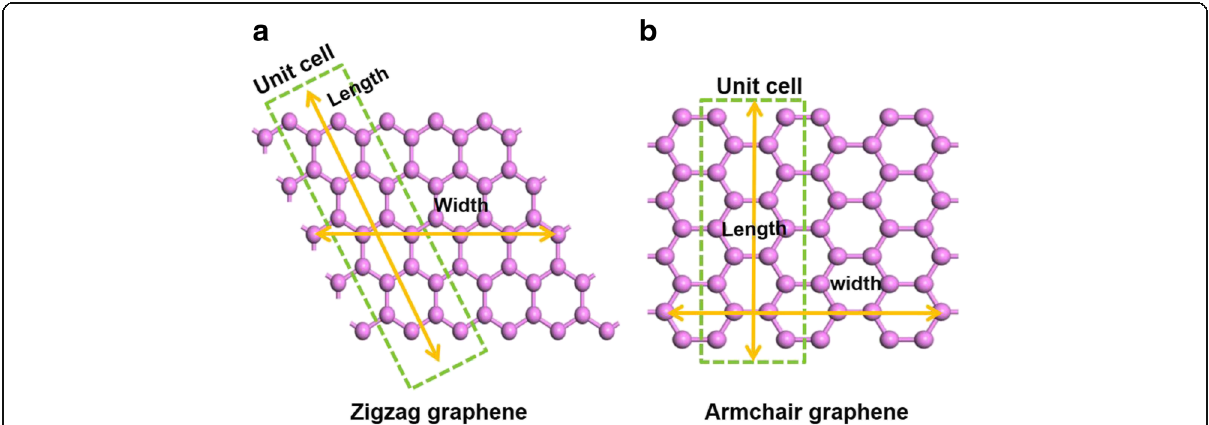
Fig. 1 The definition of the graphene ’ s size. The schematic structures of zigzag ( a ) and armchair ( b ) graphenes that illustrate the definition of the graphene ’ s size. A unit cell is set as a carbon ring in the green box. The yellow arrows represent the direction of width and